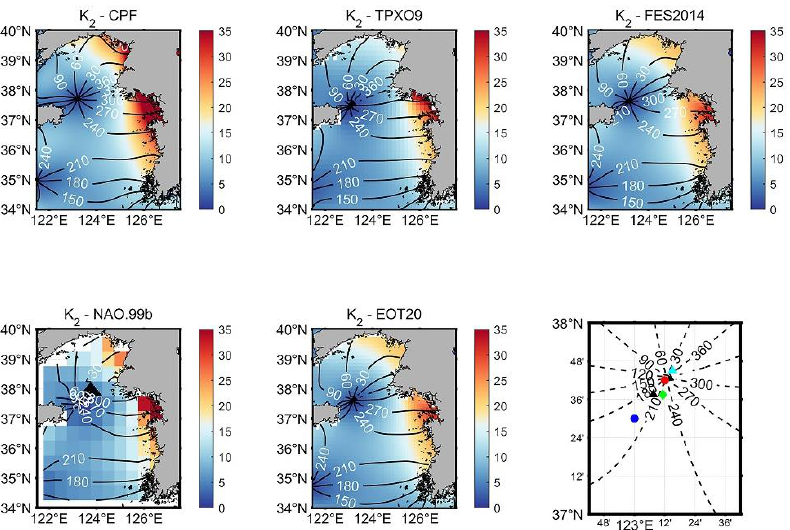
Figure 9. The cotidal charts of the N 2 constituent from the CPF method and the TPXO9, FES2014, NAO.99b and EOT20 models, and the amphidromic points of the CPF method and the four models (unit: cm).